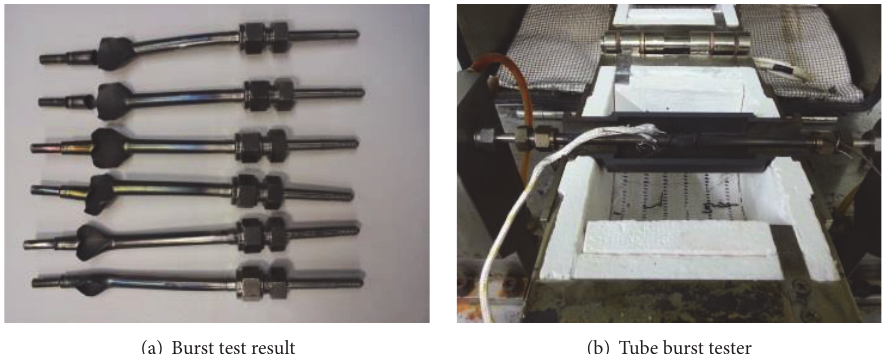
Figure 18: Burst test of fuel